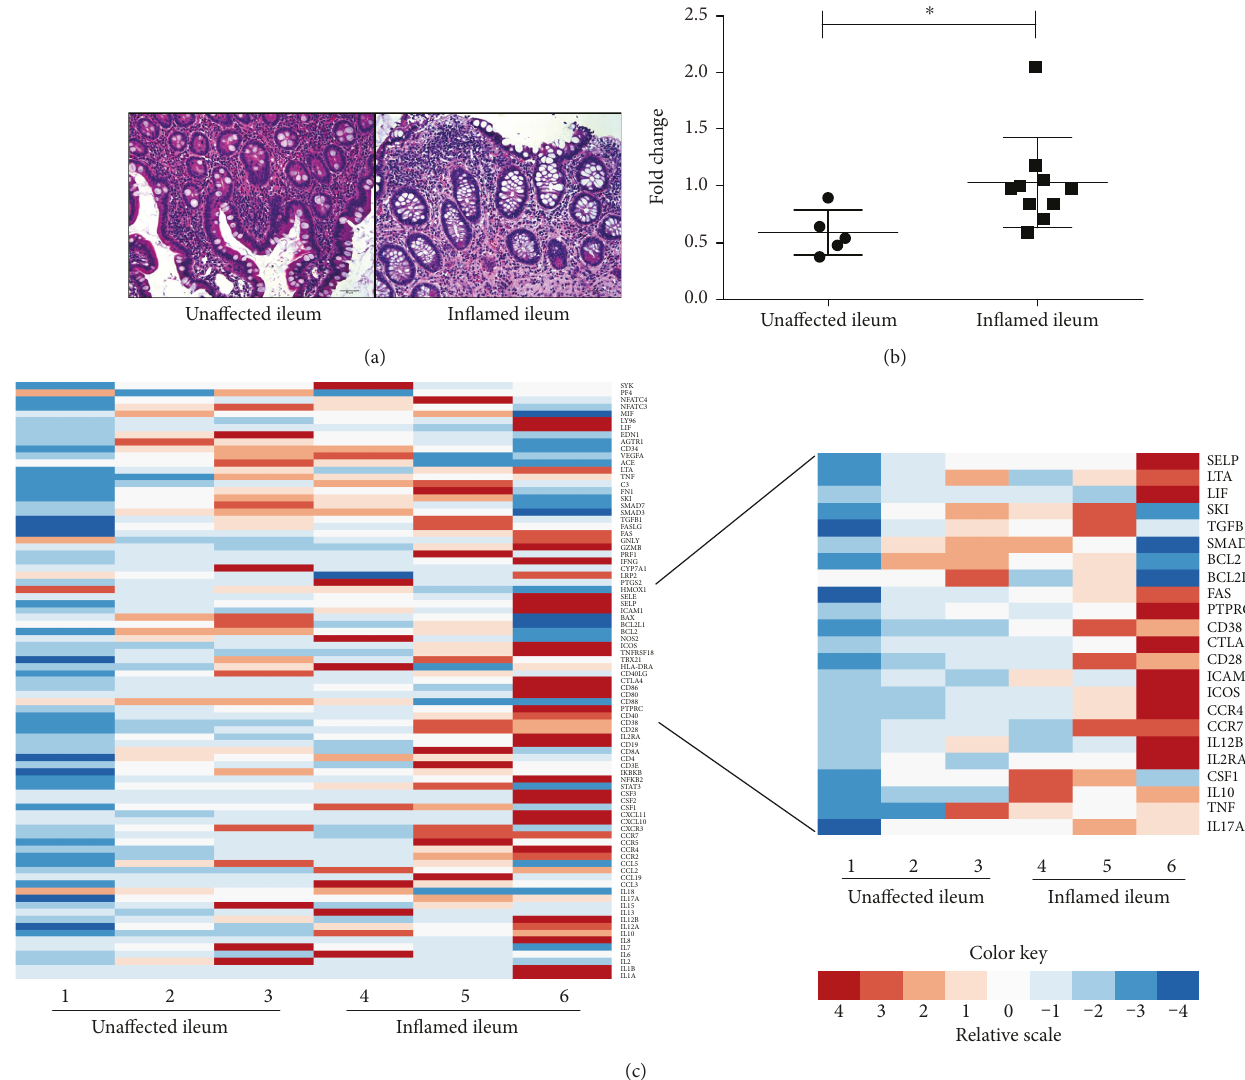
Figure 2: Increased STAT3 target gene expression and stat3 mRNA expression in the in fl amed ileum of Crohn ’ s disease patients. (a) Representative H&E staining illustrates histological appearance in una ff ected and in fl amed terminal ileum of CD patients. Compared to una ff ected ileum, the in fl amed ileum showed distinct histological signs of in fl ammation, including increased in fi ltration of immune cells in the lamina propria, loss of intact small intestinal architecture, and ulceration. Images were obtained under 20x magni fi cation. Scale bar = 50 μ m . (b) stat3 mRNA expression was upregulated in the in fl amed ileum of CD patients ( n = 10 ), compared to una ff ected ileum tissues ( n = 5 ). The gene expression fold change was calculated as 2 ^ - ΔΔ Ct value, using GAPDH as endogenous control. Statistical analysis was done by the unpaired Mann-Whitney t test, α = 0 05 . (c) Altered expression pattern of in fl ammatory genes in the in fl amed tissues of CD patients. Among these genes, an increased STAT3-related gene expression was observed in the in fl amed ileum of CD patients. GAPDH was used as endogenous